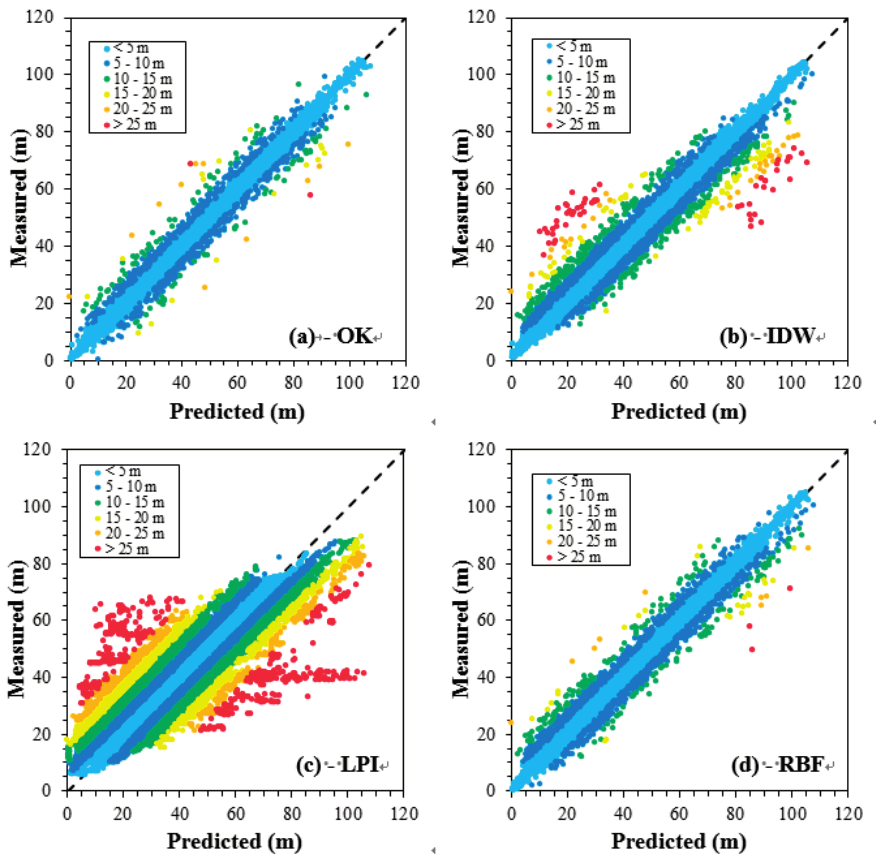
Figure 4. 2D color scatter-plot between measured and estimated depth values: ( a ) Ordinary Kriging—OK; ( b ) Inverse Distance Weighting—IDW; ( c ) Local Polynomial Interpolation—LPI; ( d ) Radial Basis Function—RBF. The color code indicates the absolute error